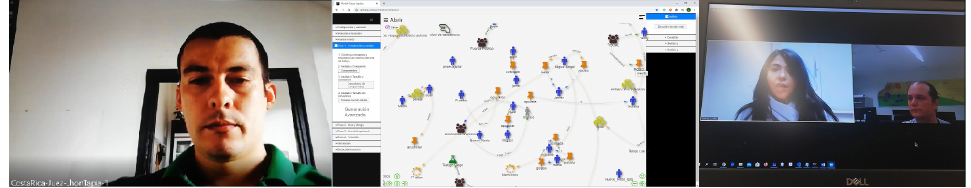
Figure 15. Real live experiment samples using the RYEL system by judges from Costa Rica and Argentina,